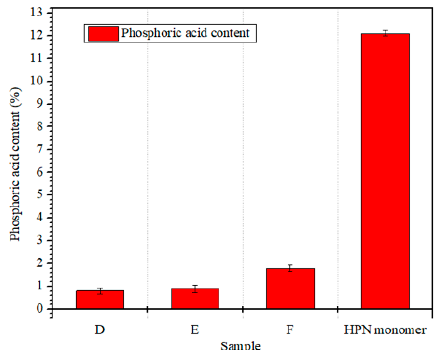
Figure 6. Phosphoric acid content of HPN-EPPA-UR-PA resin, D: 10 wt% urea; E: 5 wt% urea; F: